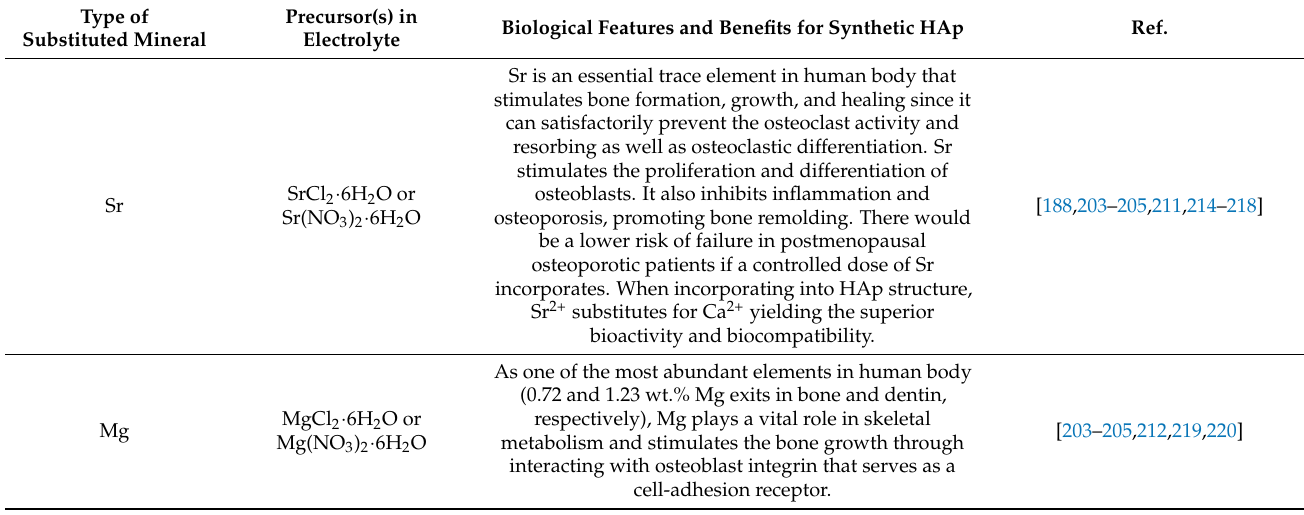
Table 8. The potential minerals that can be doped into HAp as well as their precursors and benefits. Type of Precursor(s) in Biological Features and Benefits for Synthetic HAp Substituted Mineral Electrolyte